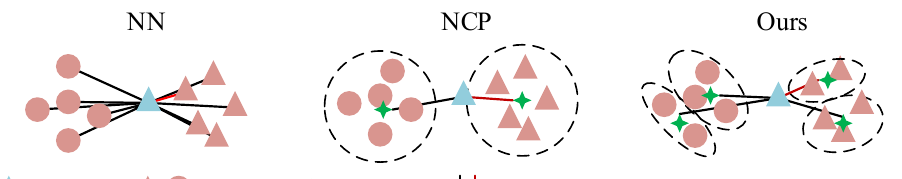
Figure 2. A graphical illustration of the nearest neighbor, nearest class prototype (NCP), and the proposed modified NCP. NN searches for the nearest samples, and NCP seeks the nearest class prototype, while our modified NCP finds a balance between them. Samples from each class are first clustered into several groups, and the goal is to find the nearest group